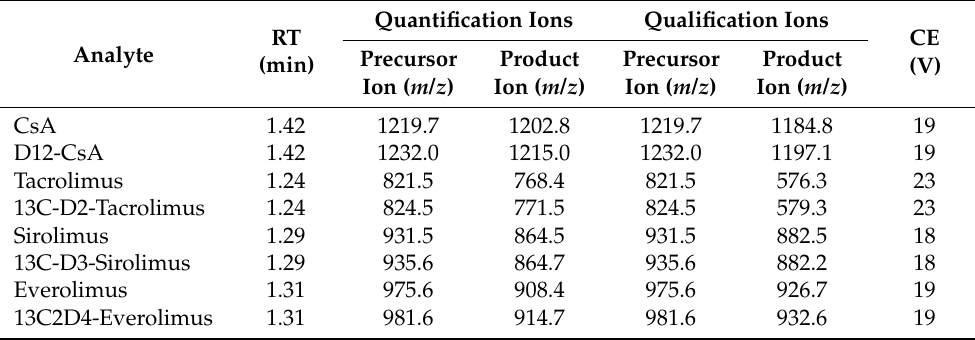
Table 1. MRM transitions adopted for analysis with Shimadzu–Recipe. Monitored analytes are listed together with the corresponding retention time (RT), precursor, and product ions used both for quantification and for qualification, and collision energy